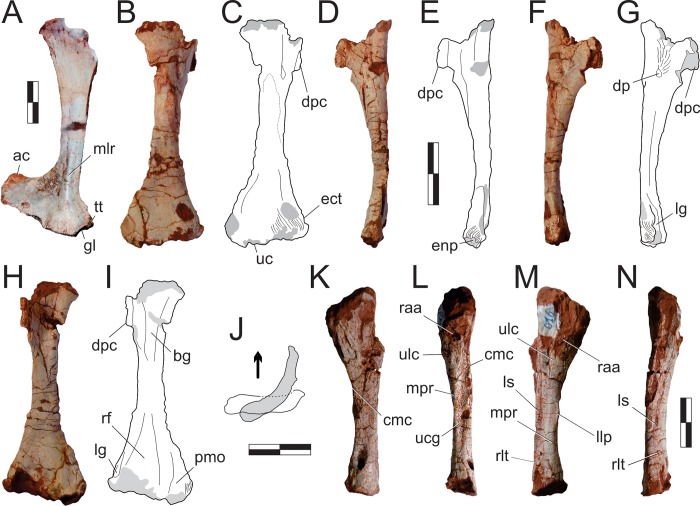
Pampadromaeus barberenai (ULBRA-PVT016), pectoral skeleton.Photographs (A-B,D,F,H,K-N) and drawings (C,E,G,I-J) of the right pectoral elements. A, Scapula in medial view. Humerus in medial (D-E), caudal (B-C), lateral (F-G), and cranial (H-I) views; J, relative position of proximal (in grey) and distal ends (arrow points cranially). Ulna in medial (K), cranial (L), lateral (M), and caudal (N) views. Abbreviations: ac, acromion; bg, biceps gutter; cmc, ulnar craniomedial corner; dp, deltoid pit; dpc, deltopectoral crest; ect, ectepicondyle; enp, entepicondyle pit; gl, glenoid; lg, ectepicondyle ligament groove; llp, lip-like projection; ls, lateral sulcus; mlr, medial longitudinal ridge; mpr, medial process ridge; rf, radial fossa; pmo, pronator muscles origin; raa, radial articulation area; rlt, radial ligament tubercle; tt, triceps tuber, uc, ulnar condyle; ucg, ulnar cranial groove; ulc, ulnar lateral crest. Sediment filled areas in grey. Except in J, grey areas indicate broken surfaces. Scale bars = 2 cm.